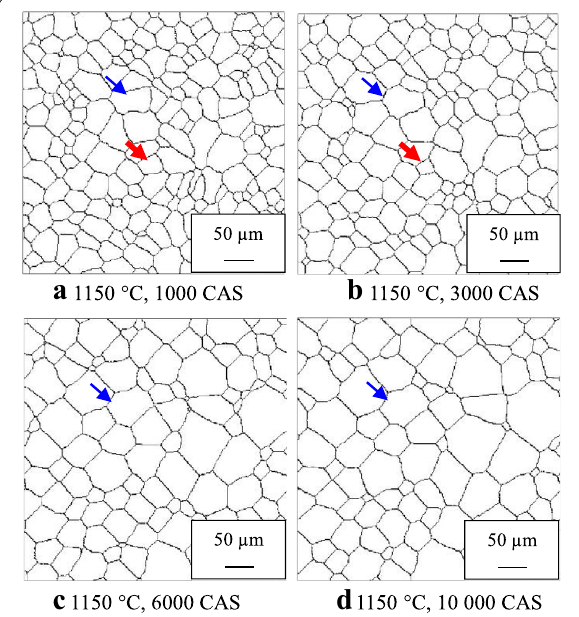
Figure 9 Grain microstructural evolution observed under different CA simulation conditions